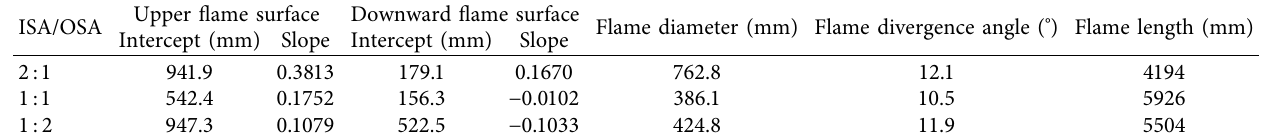
Table 3: Flame shapes size for different